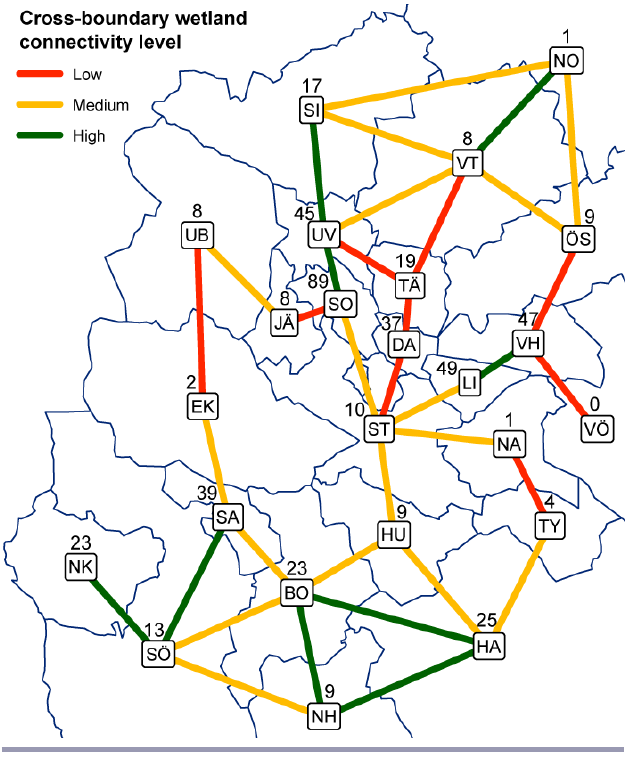
Fig. 5 . Cross-boundary ecological connectivity between adjoining municipalities, given by Eq. 2. Link color represents the summed dIIC for all links and nodes crossed by a specific municipal boundary. Absence of a link means that no wetland or wetland link up to 5 km is intersected by the boundary. Numbers represent a municipality’s cross-boundary percentage of wetland connectivity. For example, cross-boundary elements equal 17% of all SI’s nodes’ and links’ dIIC. The names of the municipalities are abbreviated as follows: BO = Botkyrka, DA = Danderyd, EK = Ekerö, HA = Haninge, HU = Huddinge, JÄ = Järfälla, LI = Lidingö, NA = Nacka, NO = Norrtälje, NK = Nykvarn, NH = Nynäshamn, SA = Salem, SI = Sigtuna, SO = Sollentuna, ST = Stockholm, SÖ = Södertälje, TY = Tyresö, TÄ = Täby, UV = Upplands Väsby, UB = Upplands-Bro, VT = Vallentuna, VH = Vaxholm, VÖ = Värmdö, ÖS =